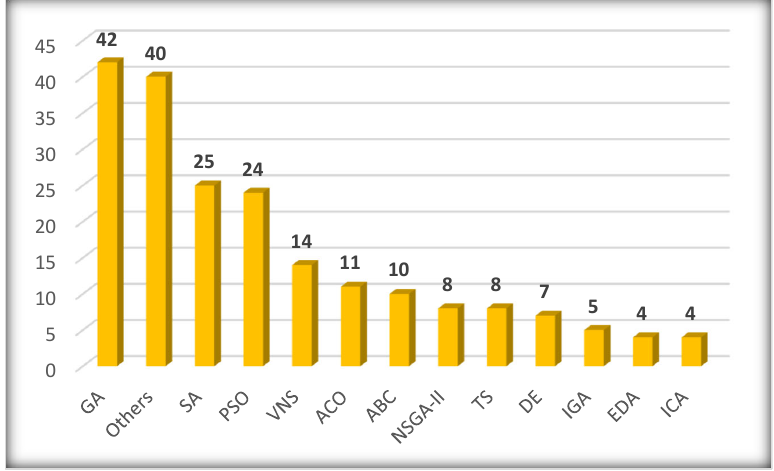
Fig. 17. Numerical analysis of metaheuristics utilized for HFSPs